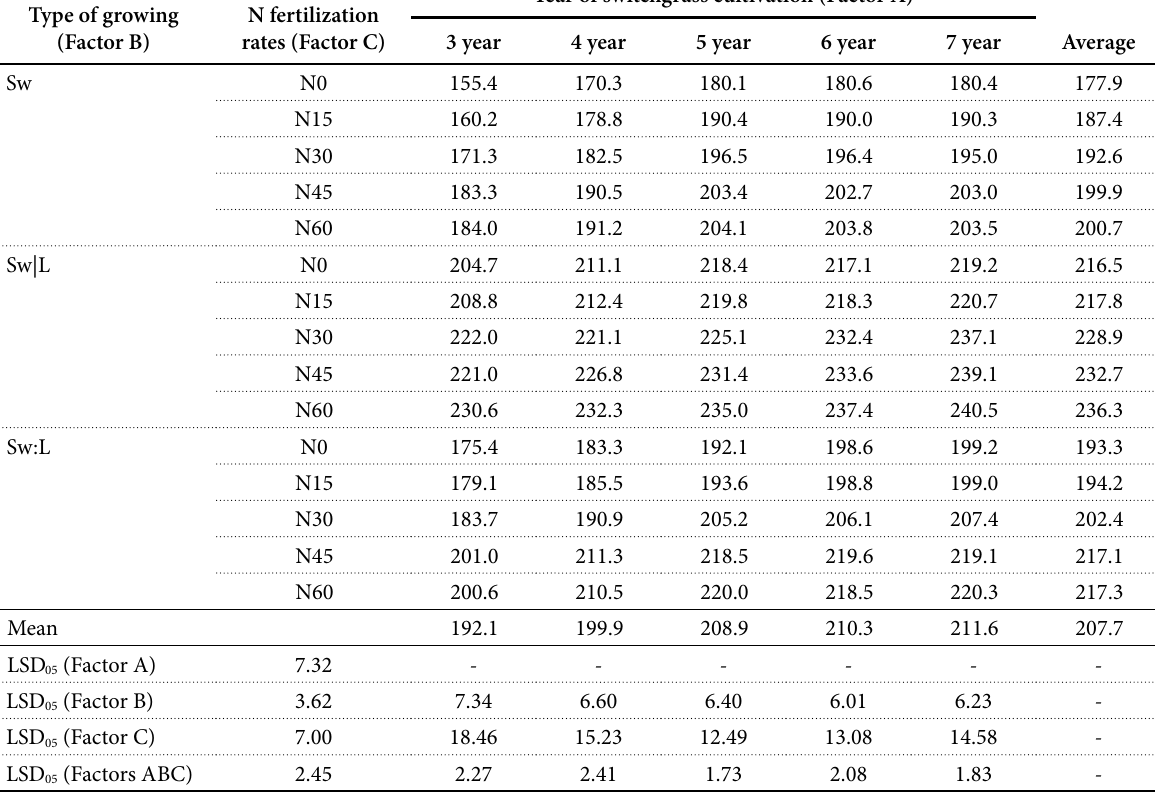
Tab. 1 Mean heights of switchgrass plants over years 3–7 of the study (cm).